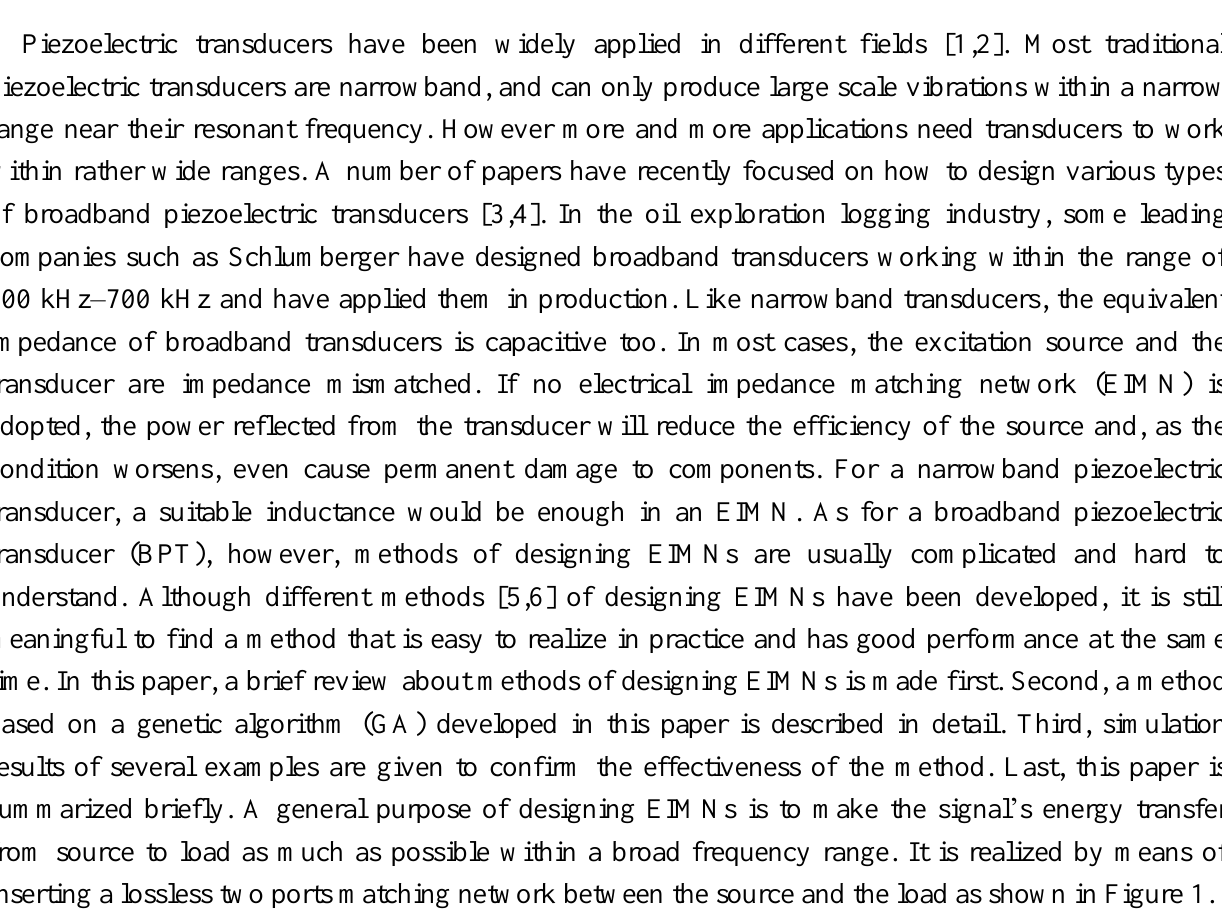
Figure 1. The matching network is inserted between the source and load.